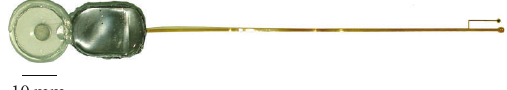
Figure 4: A photograph of retinal electrical stimulator which consists of receiver coil, hermetically sealed metal package, and polyimide-based active and reference electrodes.